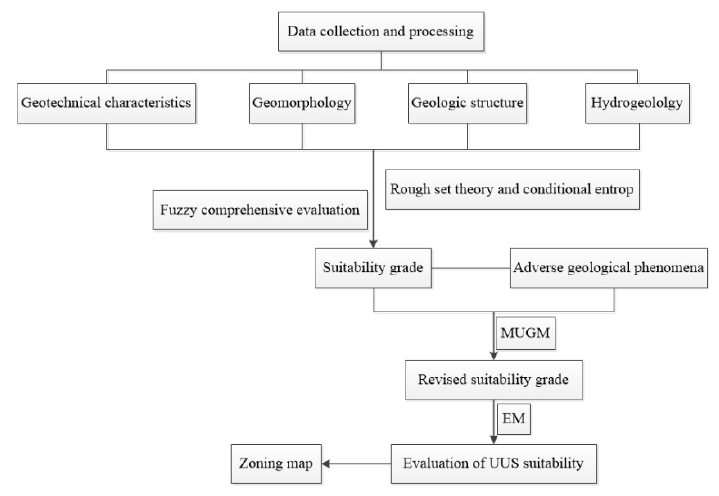
Figure 2. Flow chart of UUS suitability evaluation.